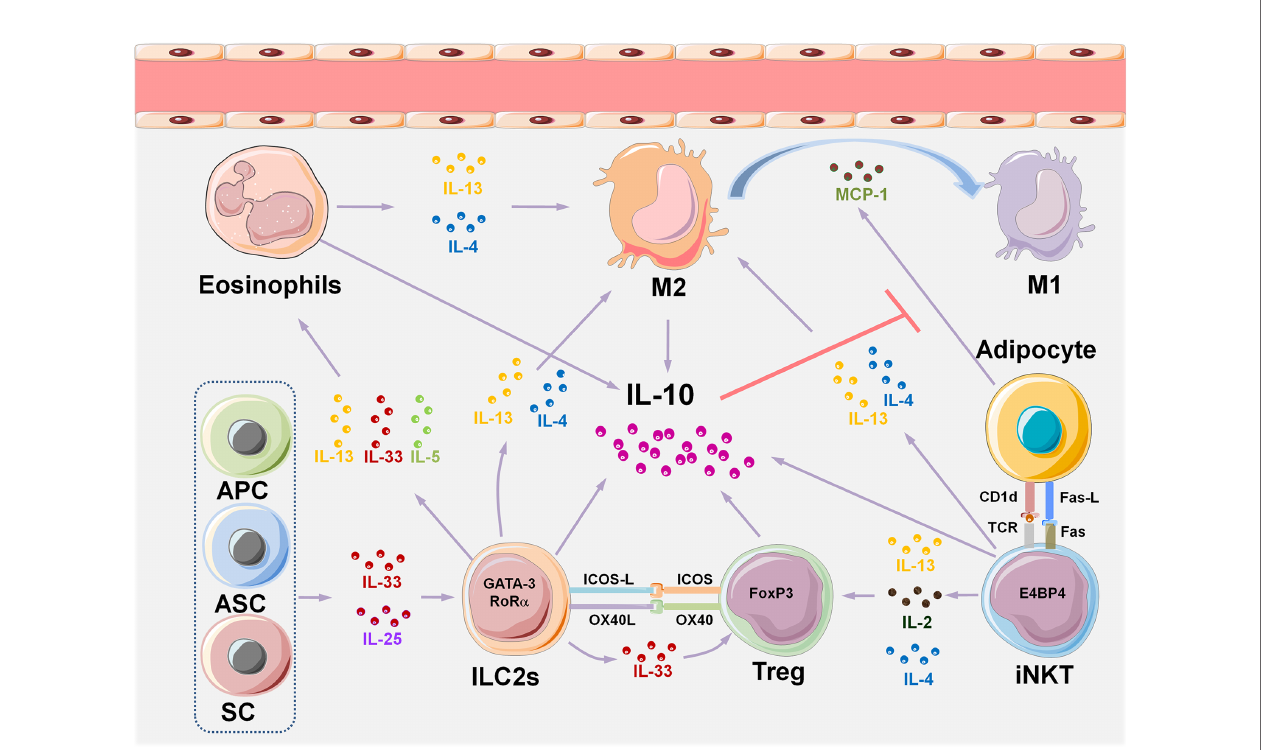
FIGURE 1 | VAT immune cell composition and multiple interactive regulatory networks in metabolic homeostasis. A variety of tissue-resident innate immune cells are distributed in VAT, either interacting with each other or with adipocytes to maintain metabolic homeostasis by producing cytokines. The IL-33/ILC2s pathway plays an initial and key role in maintaining type II immune state in VAT homeostasis. Eosinophils, M2, iNKTs, and Tregs also play a role in maintaining a steady state of VAT. IL-33 is considered to be an initial cytokine that induces and sustains the functions of ILC2s, eosinophils, M2, and Tregs. IL-10 is the core effector cytokine that maintains type II immune response in normal VAT, and almost all the VAT-resident cell types, such as eosinophils, M2, iNKTs, and Tregs produce IL-10. The critical role of IL-10 is to inhibit the production of MCP-1 by adipocytes, thereby reducing the accumulation of monocytes in adipose tissue, which prevents their polarization into pro-in fl ammatory M1. IL-10-producing iNKT cells uniquely express the transcription factor E4BP4 that controls transcription of the gene encoding IL-10 in Tregs, and differ from conventional iNKT cells which express PLZF. APCs, adipose progenitor cells; ASCs, adipose stem cells; SCs, stromal cells; ILC2s, group 2 innate lymphoid cells; VAT, visceral adipose tissue; M2, type II macrophages; M1, type I macrophages; iNKTs, invariant natural killer T cells; MCP-1, monocyte chemotactic protein 1; Tregs, regulatory T cells; E4BP4, E4 promoter-binding protein 4; PLZF, promyelocytic leukemia variant fusion